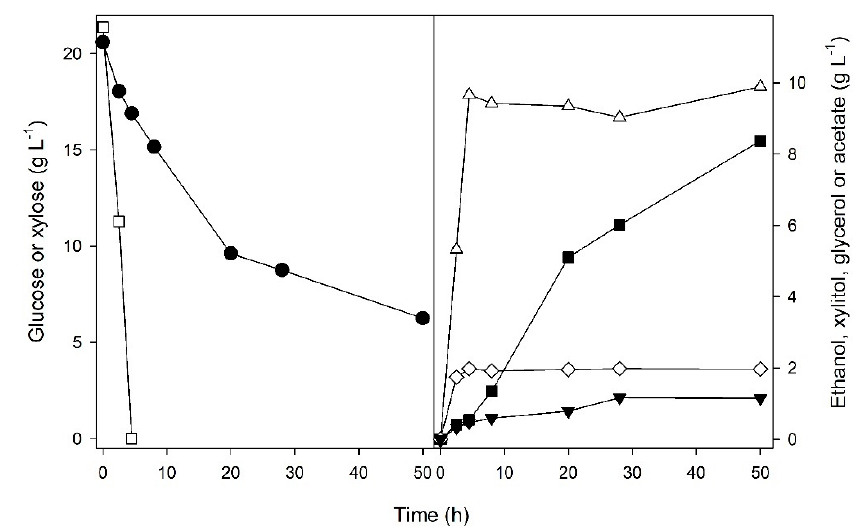
Figure 3. Time course of xylose (black circles) and glucose (white squares) consumption, and xylitol (black squares), ethanol (white triangles), glycerol (white diamonds), or acetate (inverted black triangles) production during 2% xylose plus 2% glucose batch co-fermentations in YNB medium by yeast cells of strain ASY-2 transformed with plasmids pPGK- SaXYL1 and pTEF- SpXYL2.2 .